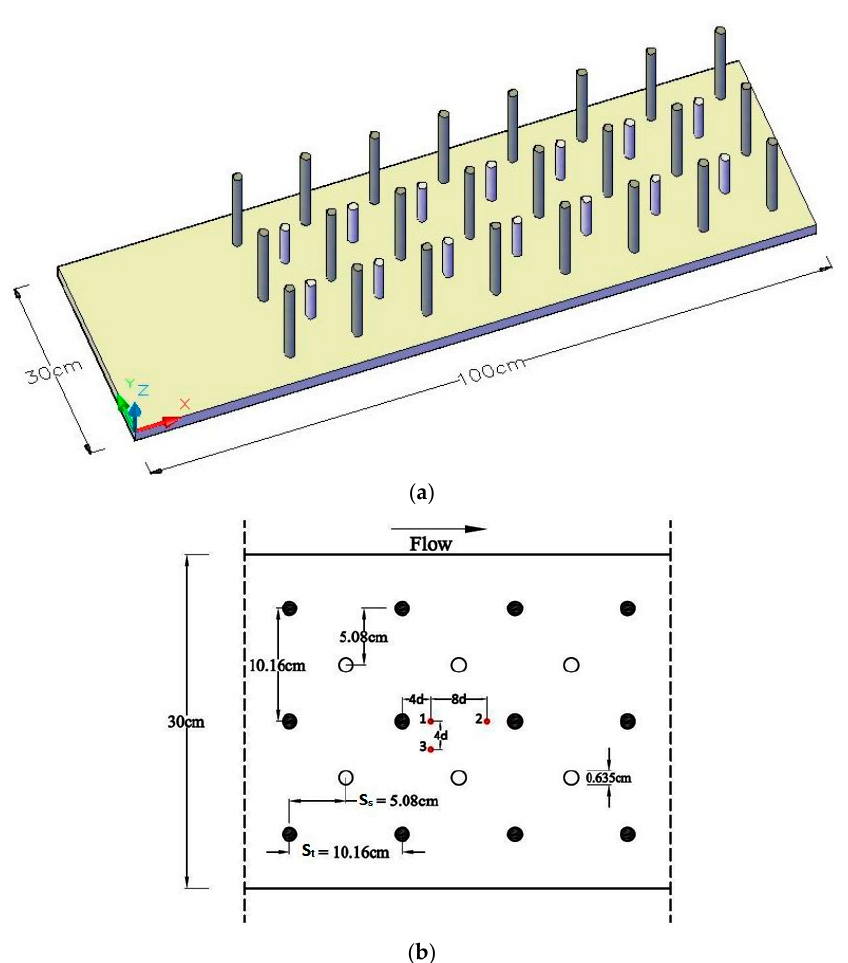
Figure 1. Experimental model geometry of Liu et al. [27] in ( a ) isometric view, and ( b ) close top view showing specific locations (i.e., 1, 2, 3) in red color.